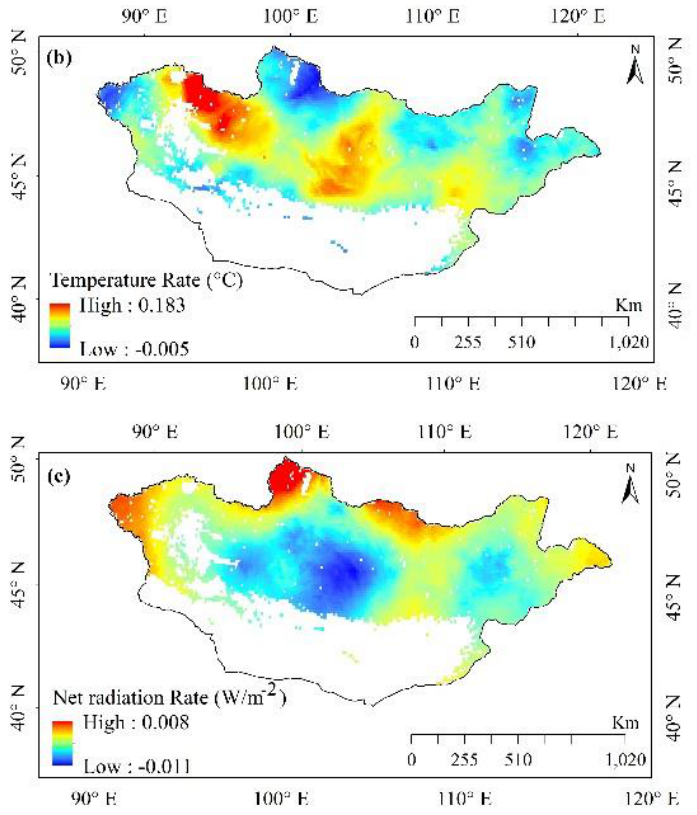
Figure A1. Spatial pattern of the trend in ( a ) growing season total precipitation, ( b ) growing season mean temperature, and ( c ) growing season mean net radiation in Mongolia from 2003 to 2018.